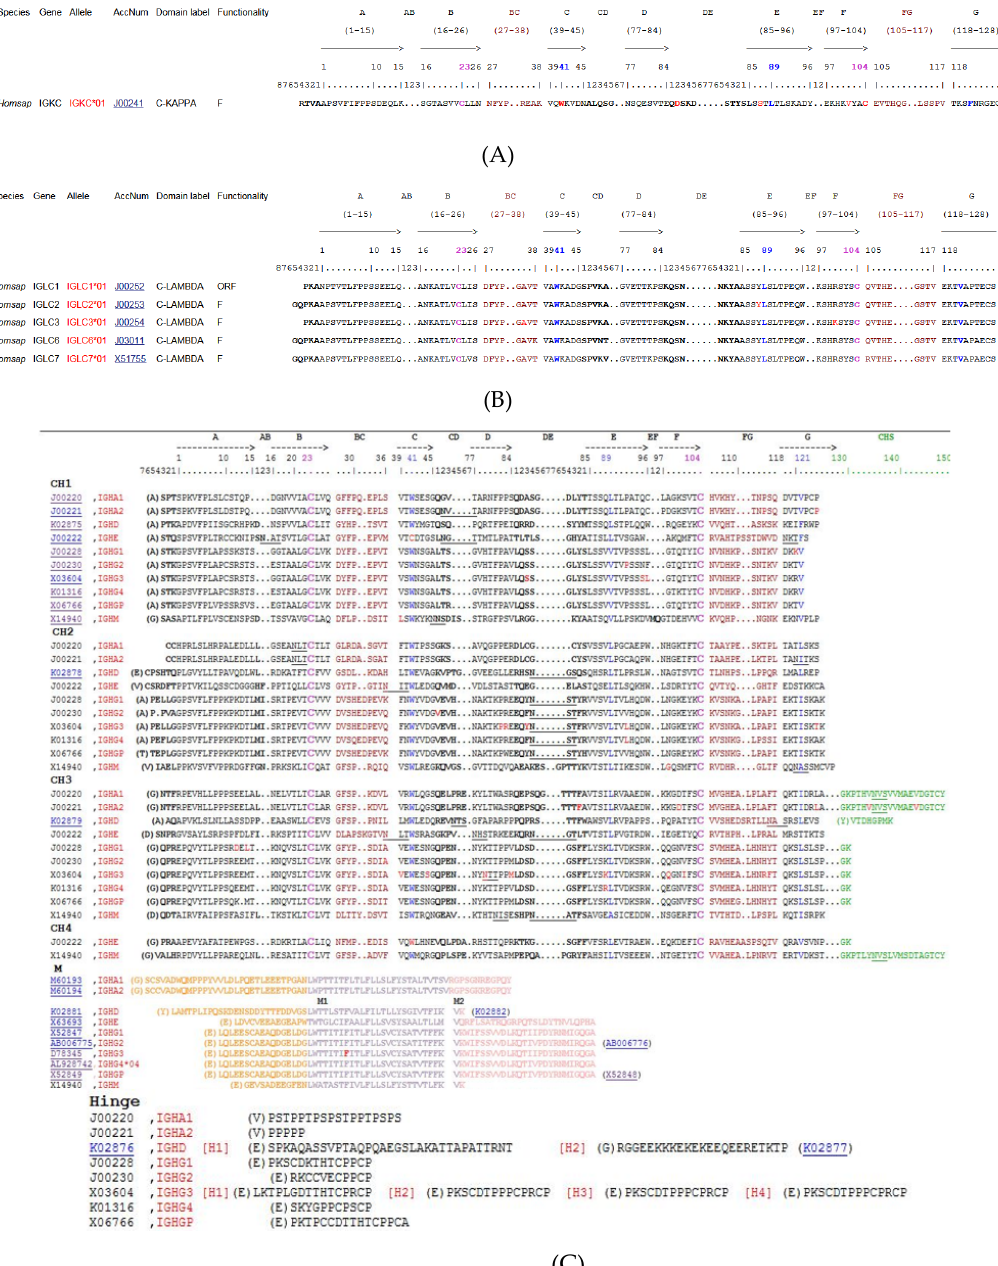
LAMBDA domains (Figure 24A,B).The Protein display of the C ‐ REGION of the IGHC genes (Figure 24C) is shown per CH domain and comprises, in addition to the 3 or 4 CH domains, the hinge region for the H ‐ alpha, H ‐ delta and H ‐ gamma chains and, for the membrane IG (mIG), the region CO + TM + CY (encompassing the connecting region (CO), the transmembrane region (TM) and the cytoplasmic region (CY) (Table 1) with delimitation of the exons M or M1 and M2 [2]) and for the secreted IG (sIG), the CHS (expressed instead of CO + TM + CY).